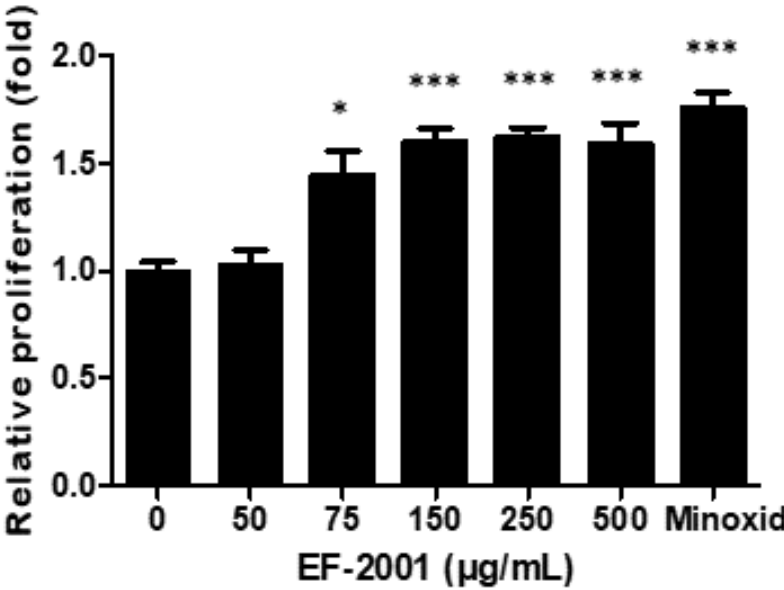
Figure 1. Effect of minoxidil and EF-2001 on the proliferation of human dermal papilla cells (HDPCs) determined by MTT assay. Minoxidil (3 µ M) and EF-2001 (at various concentrations) induced the proliferation of HDPCs, measured by determining optical density at 595 nm using a microplate reader. Data are expressed as the mean ± SD ( n = 4). * p < 0.05, *** p < 0.001 versus control.